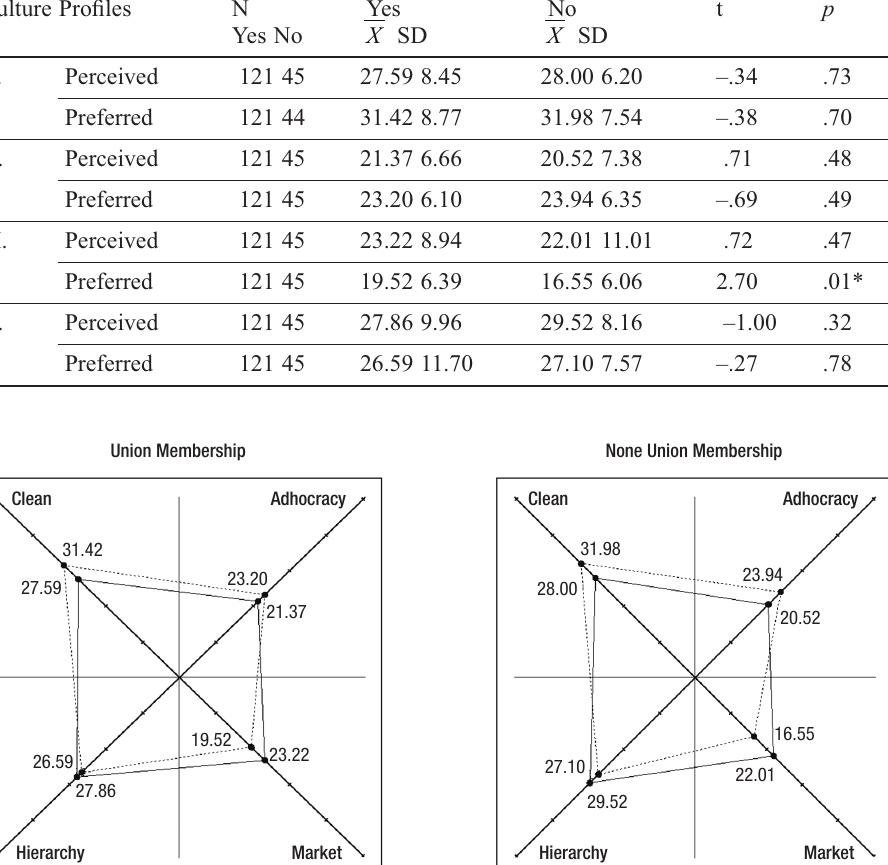
Table 5. The effect of union membership on organizational cultural profi les (* p < 0.05) Culture Profi les